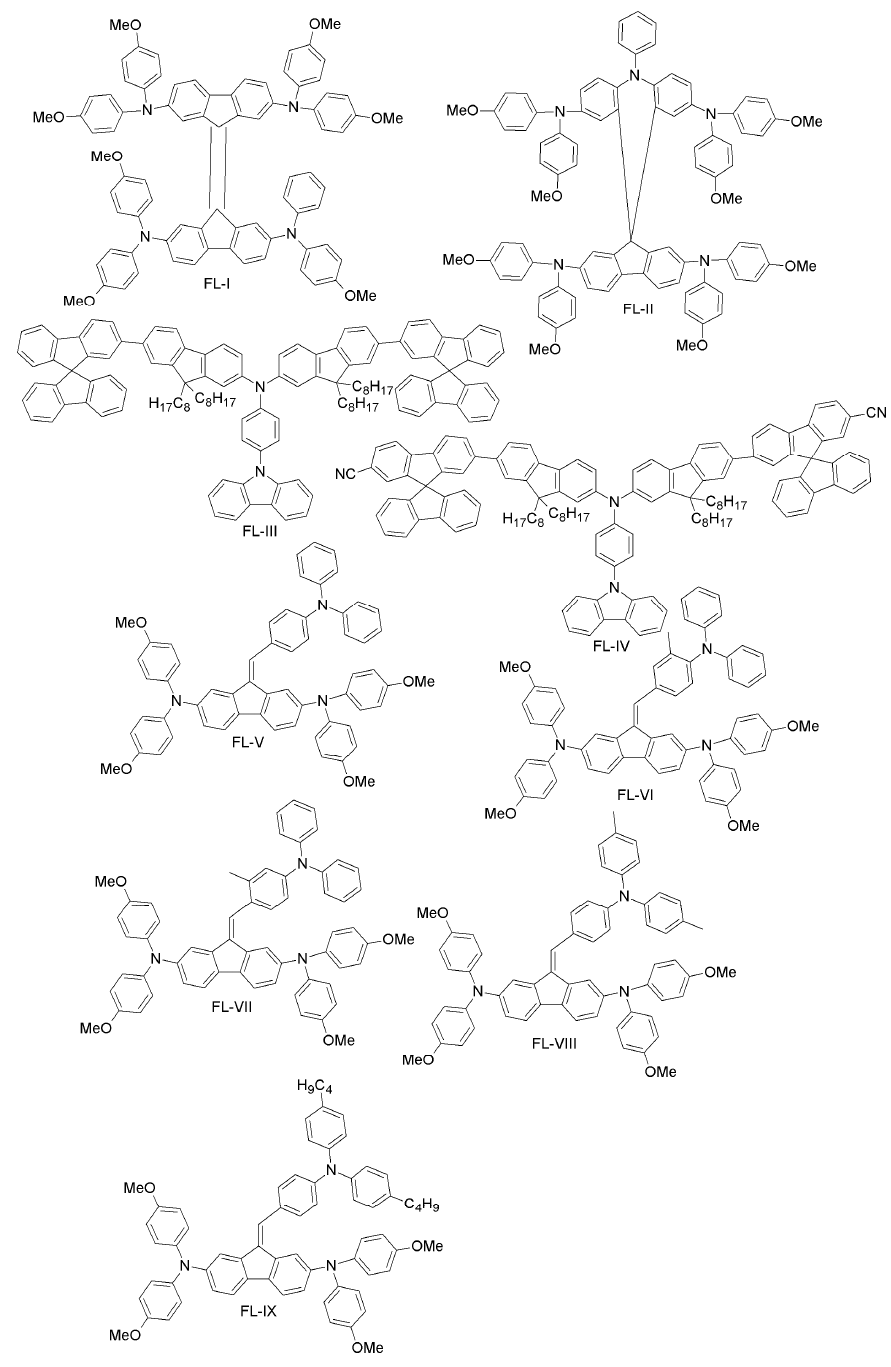
Figure 11. Fluorene-based HTMs for high-performance PSCs.